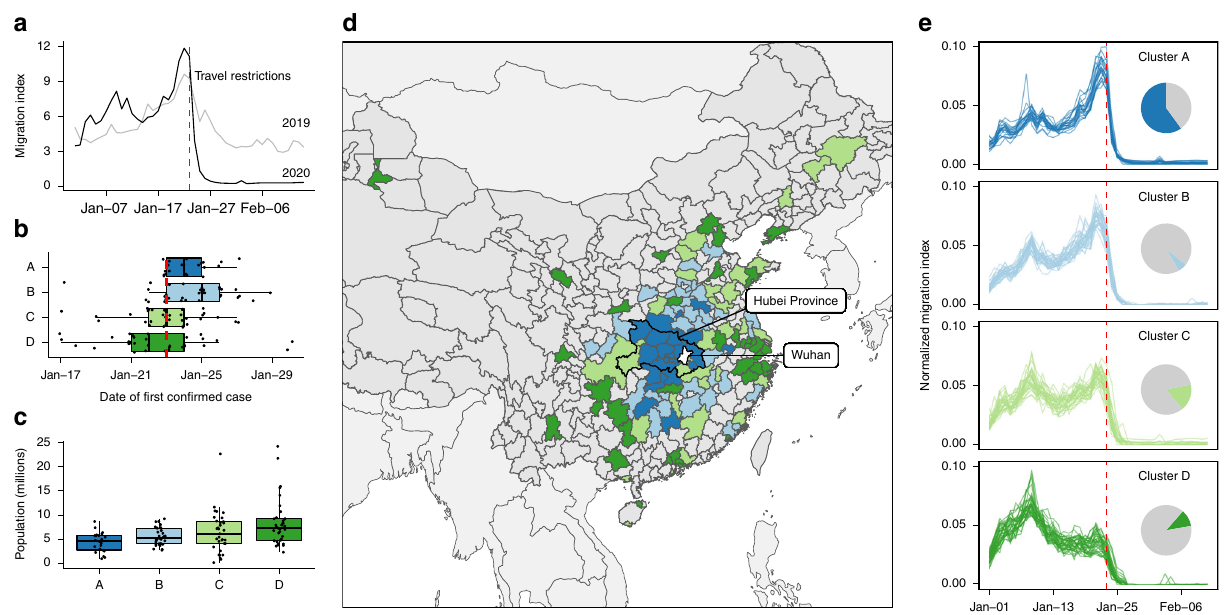
Fig. 1 Travel patterns between Wuhan and other connected prefectures. The identi fi ed patterns of outbound travel from Wuhan: ( a ) the daily total outbound travel from Wuhan in 2019 and 2020; ( b ) timing of fi rst case detection strati fi ed by clusters of similar time series; ( c ) distribution of resident population sizes of individual prefectures (points); ( d ) map of prefectures and province-level cities showing the spatial distribution of timeseries clusters; ( e ) outbound travel trends from Wuhan to the most connected prefectures in China, strati fi ed by clusters with similar time series. The clusters are de fi ned by k-means clustering of the timeseries of outbound travel volume (see “ Methods ” section). For clusters in panels b and c , n = 22 (Cluster A), 34 (Cluster B) 33 (Cluster C), 36 (Cluster D). Boxplots in panels b and c display Median, IQR, and whiskers + / − 1.5 times IQR. The timeseries have been normalised by the total fl ow of each, to allow comparison of the pro fi le. Inset pie charts show the total travel fl ux out of Wuhan prefecture by destinations in each cluster. The red dashed lines in panels a , b and e mark the beginning of LNY holidays. The colours in panels b , c , d and e indicate cluster membership (Cluster A, B, C or